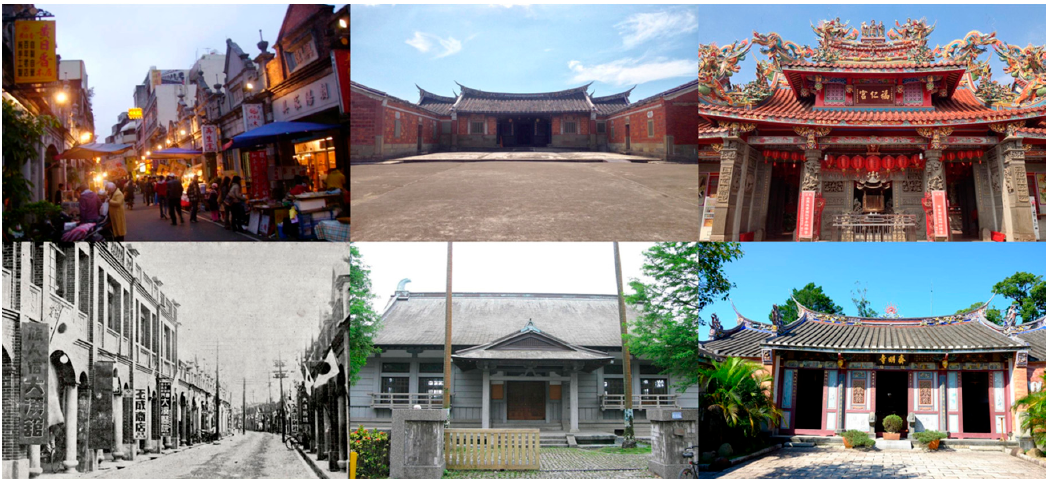
Figure 2. Cultural heritage of Daxi. Source: Based on Wikimedia Commons. Legend: Upper left shows the present Daxi Old Street, where the sale of togan is the dominant activity of the town; lower left shows the same street in Japanese colony period, implies the historic character of the town; upper middle: the Lee Teng-fan’s Ancient Residence; lower middle: Japanese historical architecture Daxi Wude Hall; upper right: Daxi Furen Temple; lower right: Daxi Zhaiming Temple.